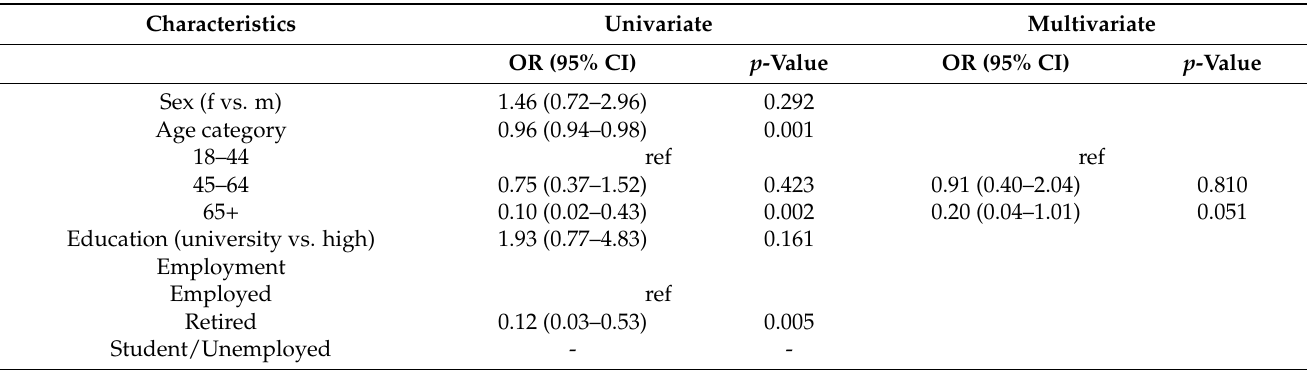
Figure 2. Titers of anti-spike immunoglobulin G in applied vaccine combinations (primary vaccina- tion series and booster dose) during the observed period. The red line represents the median IgG values; the blue circle represents the number of cases with the same IgG values.